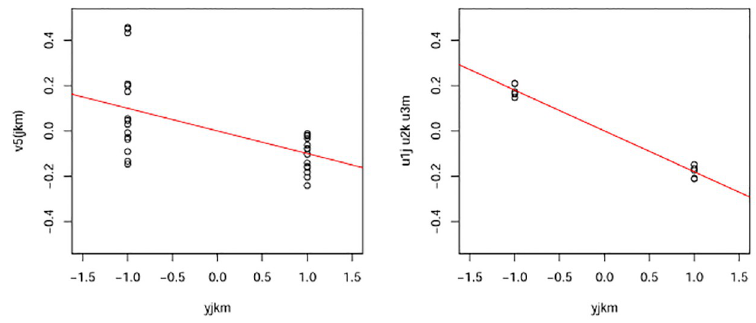
Fig 8. Comparisons between y